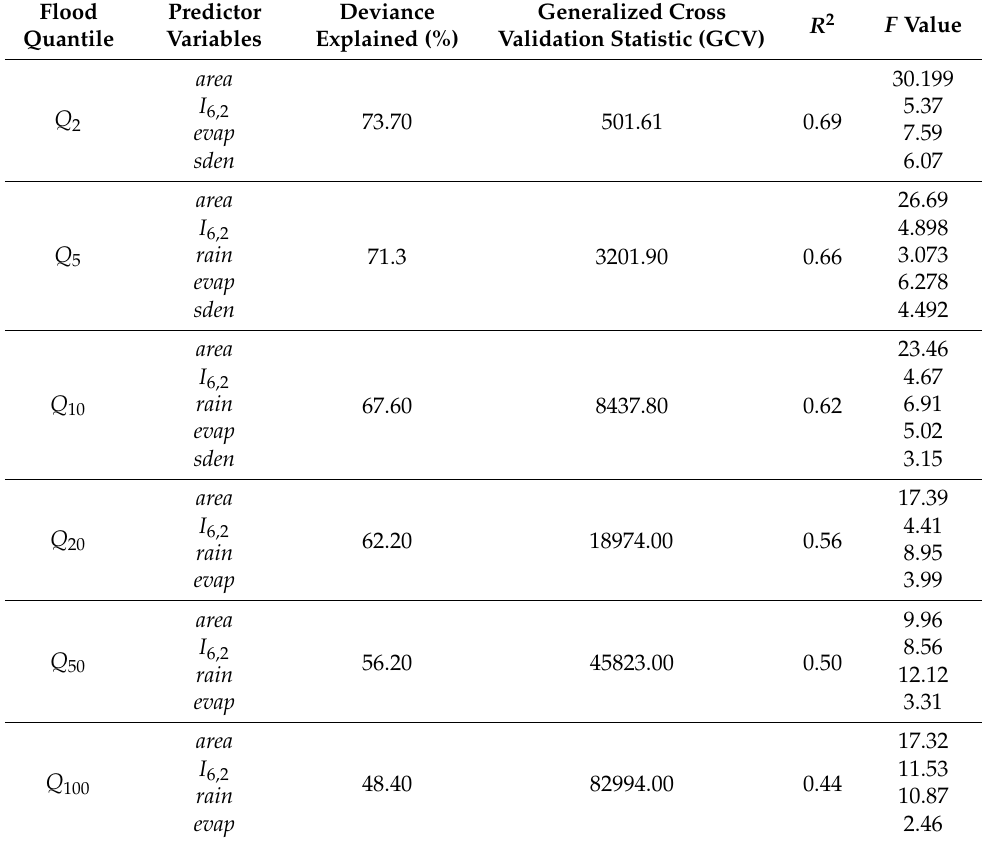
Table 3. Important model statistics for GAM models of combined